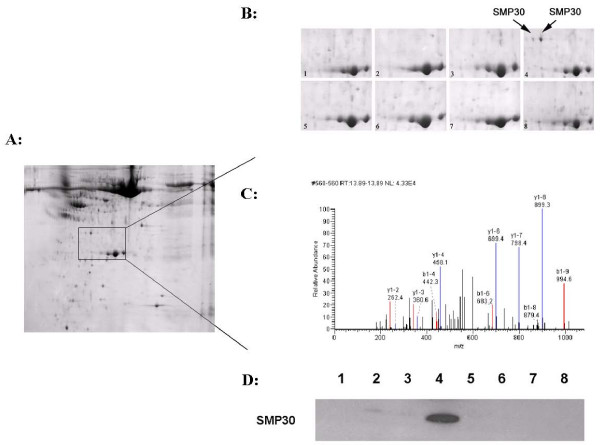
Plasma SMP30 levels were only elevated in mice with ALF. A: 2-D gel of murine plasma proteins. B: Magnified regions of 2-D gel of murine plasma proteins. The results shown are representative of three independent experiments. The protein spot corresponding to SMP30 is indicated with an arrow. C: Spectrum from LC-ESI-MS/MS analysis of the trypsin digestion products of senescence marker protein 30 (SMP30). D: WB analysis of plasma SMP30 levels in GalN/LPS-treated mice. Lane and gel 1: 5 h after saline injection; lane and gel 2: 5 h after LPS injection; lane and gel 3: 5 h after GalN injection; lane and gel 4: 5 h after GalN/LPS injection; lane and gel 5: 24 h after saline injection; lane and gel 6: 24 h after LPS injection; lane and gel 7: 24 h after GalN injection; lane and gel 8: 24 h after GalN/LPS injection.